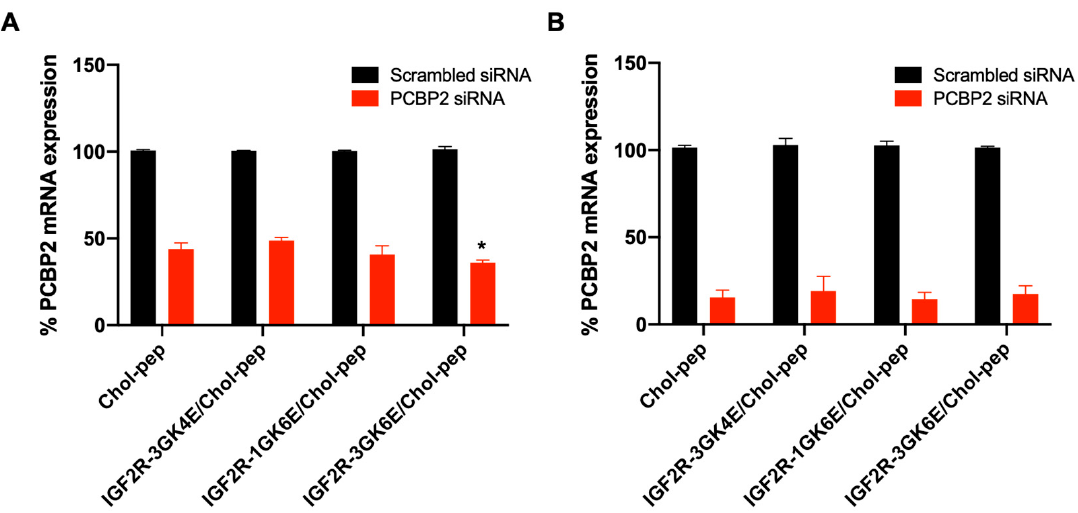
Figure 6. Silencing activity of the Pcbp2 siRNA in HSC-T6 cells. mRNA expression of the Pcbp2 gene in HSC-T6 cells after incubation with the Pcbp2 siRNA nanocomplex for ( A ) 4 h and ( B ) 24 h. Results are presented as the mean ± SD ( n = 3) (* p < 0.05).